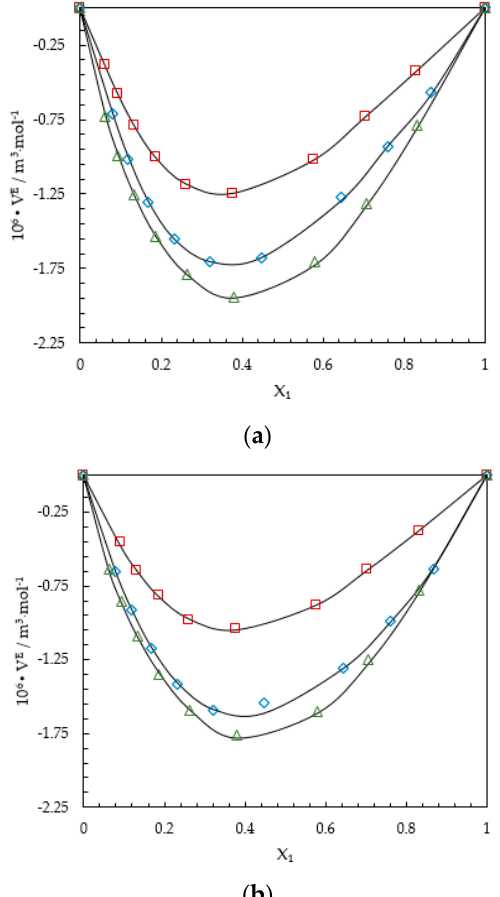
Figure 1. ( a ) Excess molar volumes 𝑉 (cid:3006) of MDEA (1) + H 2 O (2), ‘ □ ’; DMEA (1) + H 2 O (2), ‘ ◊ ’ and DEEA (1) + H 2 O (2), ‘ ∆ ’ at 293.15 K, Correlation; “ ― ”. ( b ) Excess molar volumes 𝑉 (cid:3006) of MDEA (1) + H 2 O (2), ‘ □ ’; DMEA (1) + H 2 O (2), ‘ ◊ ’ and DEEA (1) + H 2 O (2), ‘ ∆ ’ at 353.15 K, Correlation; “ ― ”.